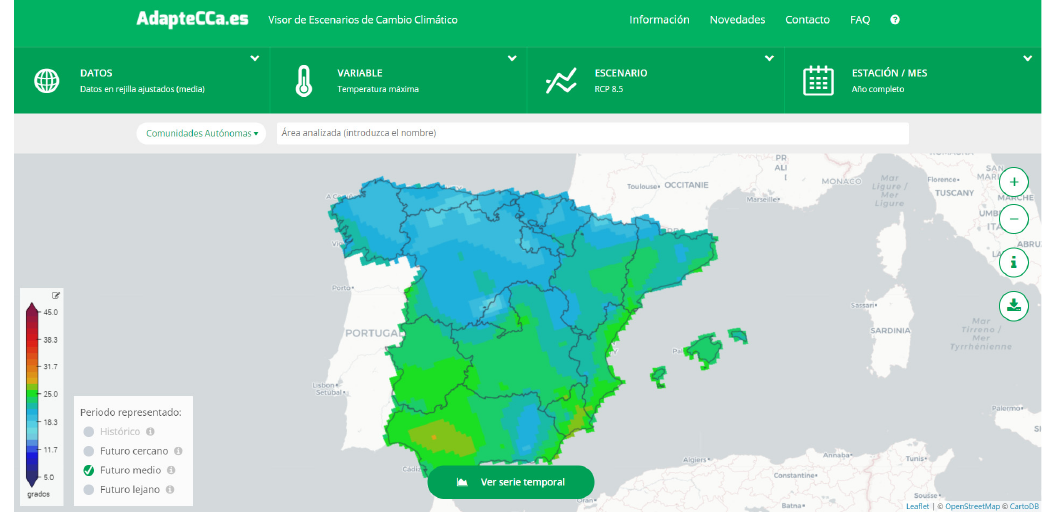
Figure A2. Overview of the resource. Source: Adaptecca.es (2021).